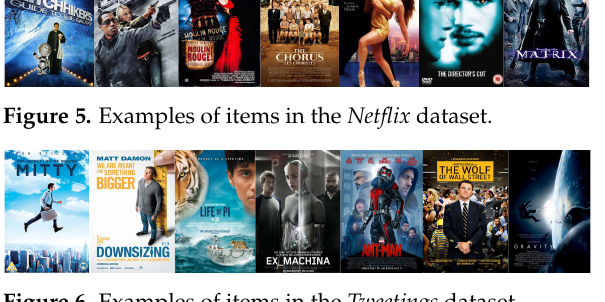
Figure 6. Examples of items in the Tweetings dataset.